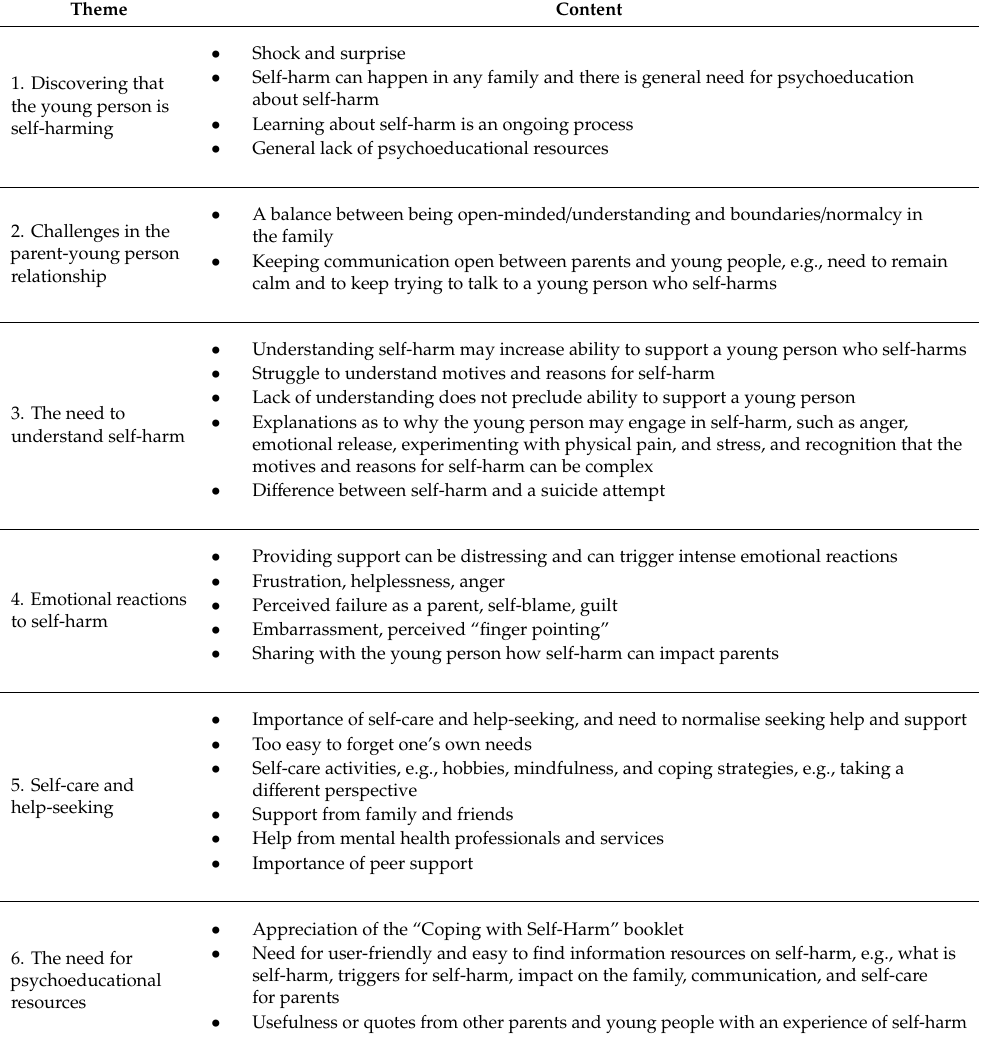
Table 1. Descriptive